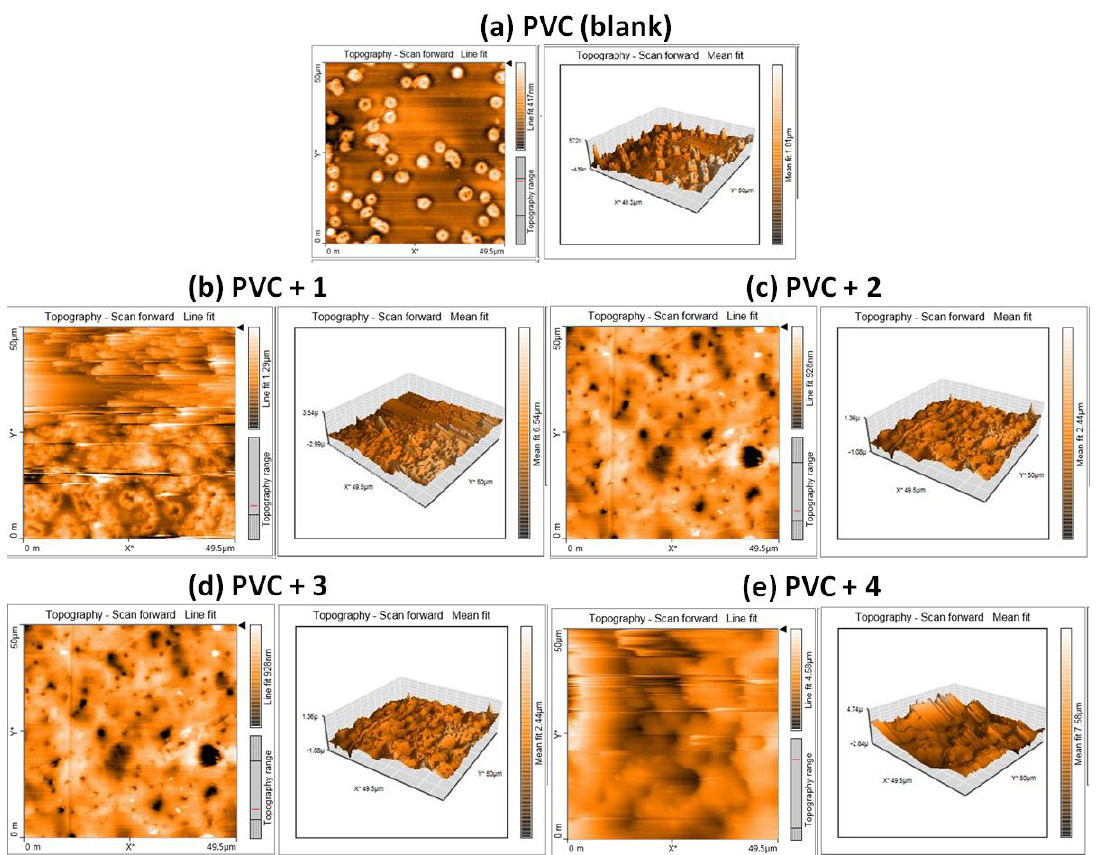
Table 5. R q values for PVC films after irradiation.